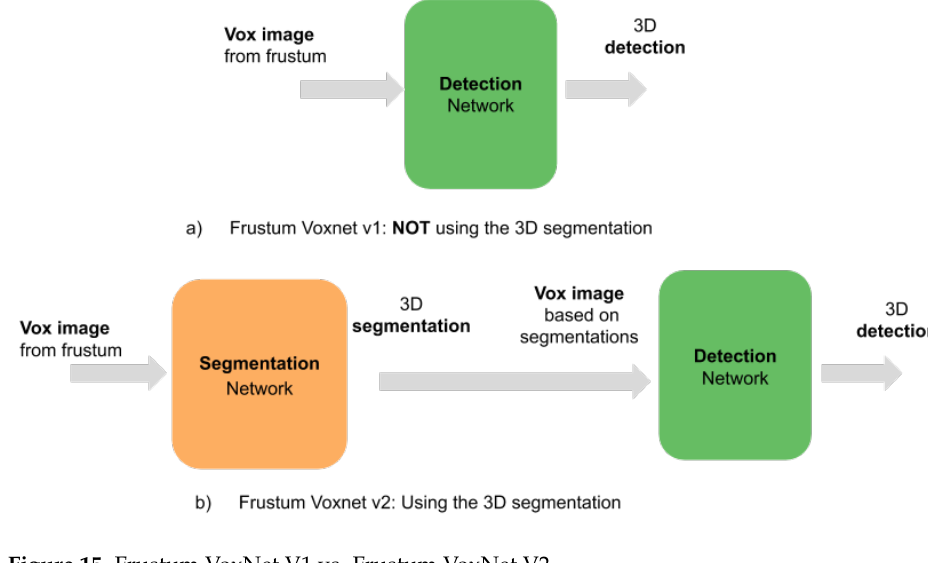
Figure 15. Frustum VoxNet V1 vs. Frustum VoxNet